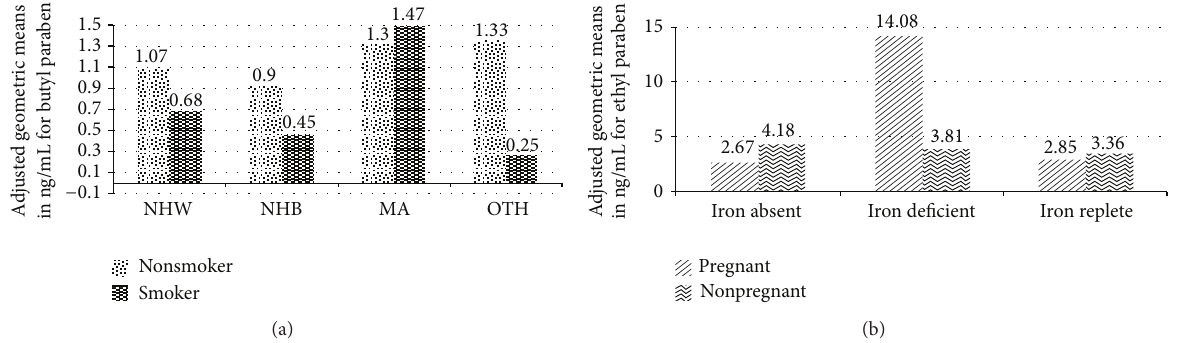
Figure 2: Adjusted geometric means in ng/mL for (a) butyl paraben by race/ethnicity (NHW = Non-Hispanic White, NHB = Non-Hispanic Black, MA = Mexican American, and OTH = other unclassified races/ethnicities) and smoking status and (b) ethyl paraben by iron storage status and pregnancy